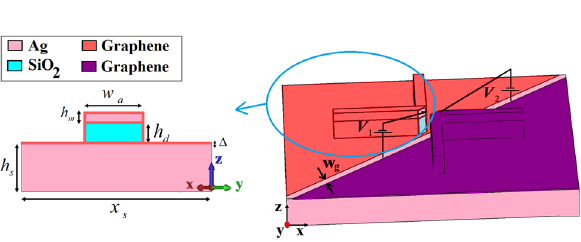
Figure 9. 3D schematic view of smart unidirectional cross dipole